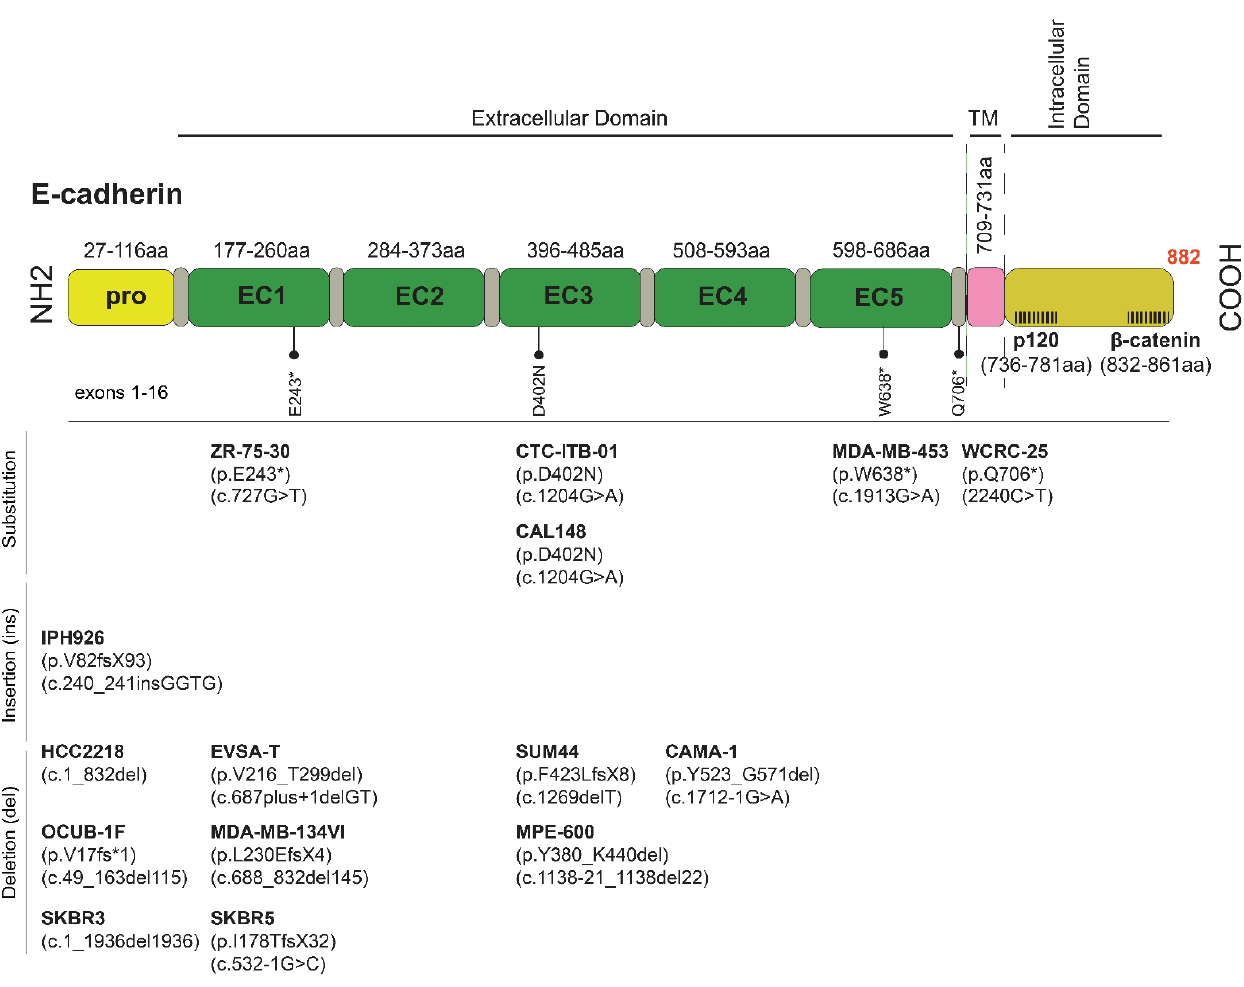
Figure 2. CDH1 mutations and sequence variants commonly found in ILC and ILC-like cell lines. Abbreviations: fs, frameshift; EC, extracellular domain; TM, transmembrane; *, termination, stop codon; X, termination; p, protein reference sequence; c, coding DNA reference sequence; del, deletion.